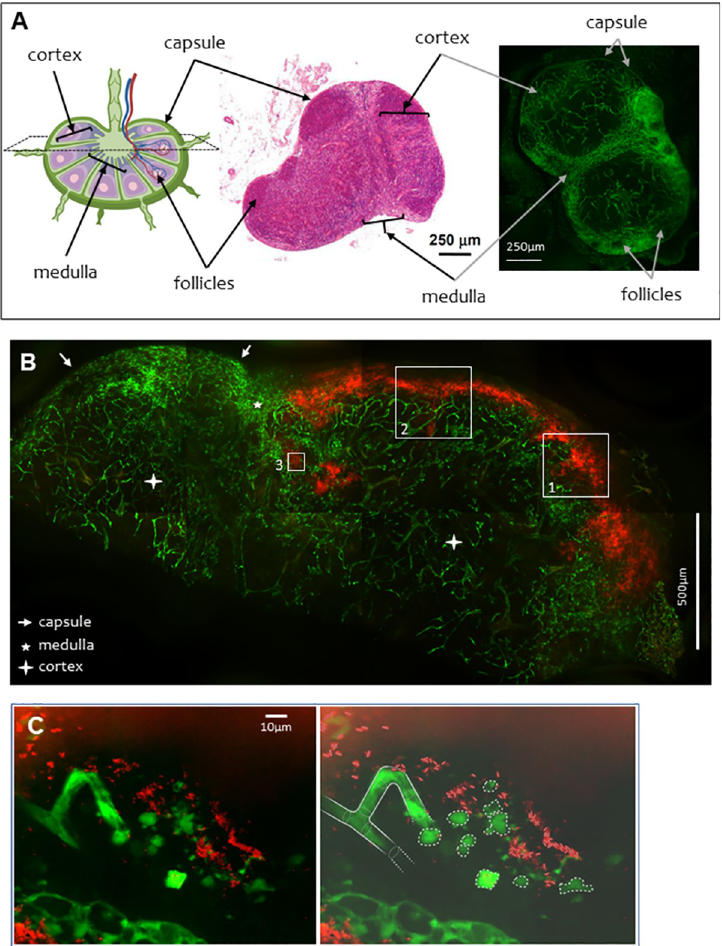
Fig 1. Confocal microscopy, observation of the blood vessels in the draining lymph-node of non-infected and Y . pestis -infected Flk1-GFP mice. A. Left, schematic of a lymph node (biorender.com) with legends indicating capsule, node cortex and medulla and follicles. Middle, histological section of a mouse inguinal lymph node (4 μ m thick) stained with hematoxylin-eosin, Bar = 250 μ m. Right, inguinal lymph node of a non-infected Flk1-GFP mouse. Image is reconstructed from 4 panels (2x2), each panel corresponding to the maximum of intensity (MIP) calculated on a 150 μ m section of the bubo. Bar = 250 μ m. B. Draining inguinal lymph node of a Y . pestis -infected Flk1-GFP mouse on D3 post infection. Lymph node is representative of features observed on five independent challenged mice. Image is reconstructed from 8 panels (2x4), each panel corresponding to the maximum of intensity (MIP) calculated on a 150 μ m section of the bubo (15 sections separated by 10um). The red color corresponds to bacteria visible in the subcapsular sinus and deeper in the lymph node parenchyma. The blood vasculature is colored in green. Frame 1 correspond to magnification on S1 Video; frame 2 correspond to magnification on S2 Video; frame 3 correspond to panel C and S3 Video. The capsule is indicated with white arrows, the medulla with a white star, and the cortex with white crosses. Bar = 500 μ m. C. The left panel shows the magnification of the central region of panel B (MIP calculated on 20 μ m, 40 sections separated by 0.5um). The right panel displays an interpretation of the picture: the blood vessel is discontinued in close proximity of groups of bacteria and individual cells or remnants of cells are surrounded by bacteria. Made with biorender. Bar = 10 μ